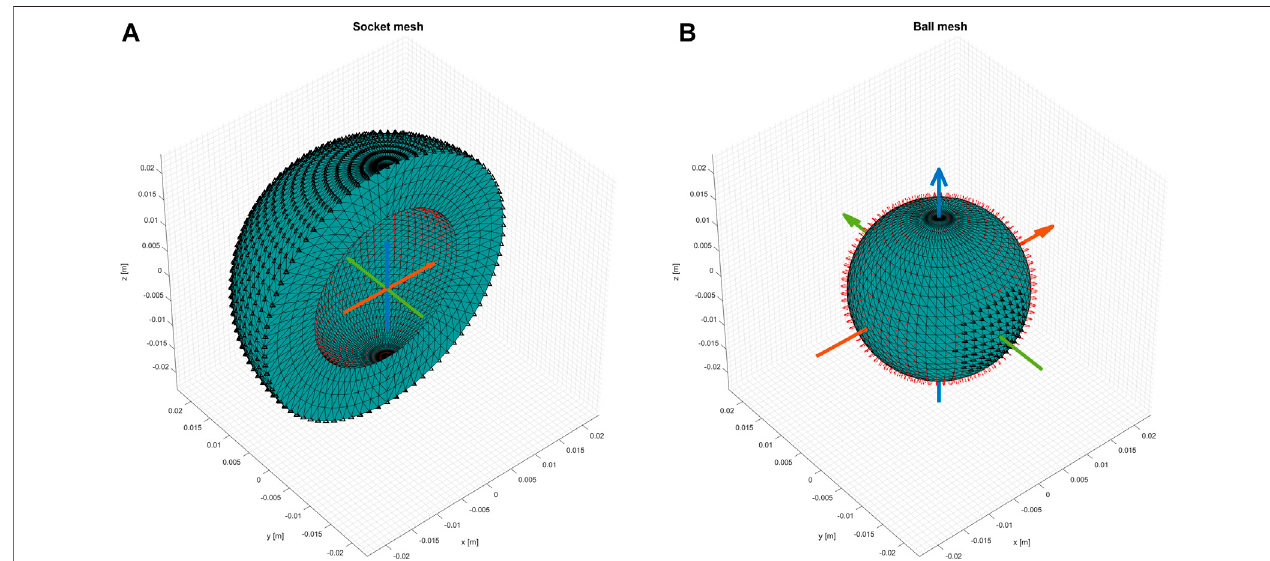
FIGURE 1 | Socket (A) and ball (B) linear tetrahedra